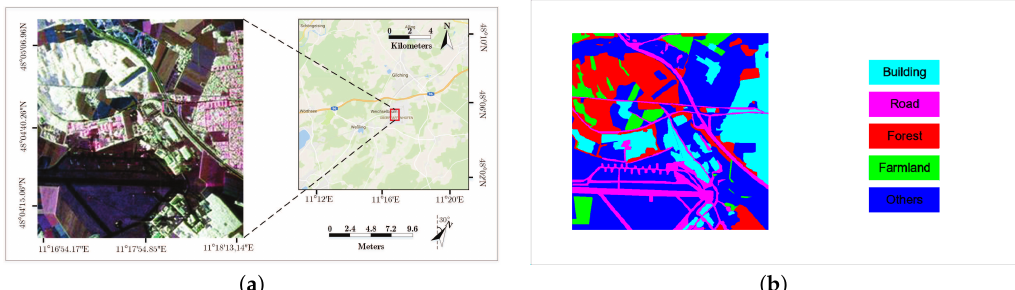
Figure 6. Experiment data1. ( a ) The ESAR image data; ( b ) The ground truth of ESAR image.